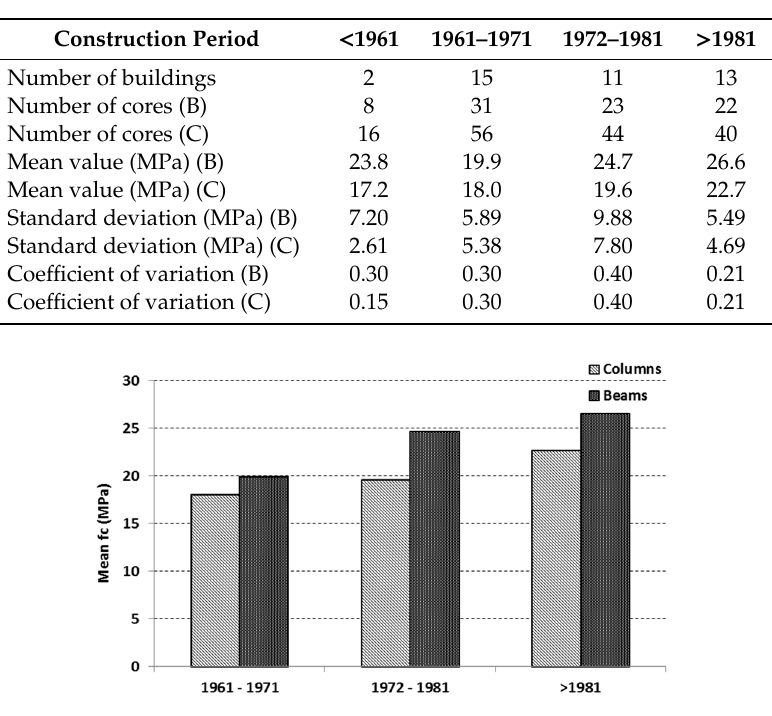
Table 2. Statistical data of the subset of concrete strength values regarding buildings with cores extracted from beams and columns (B = beams, C = columns).